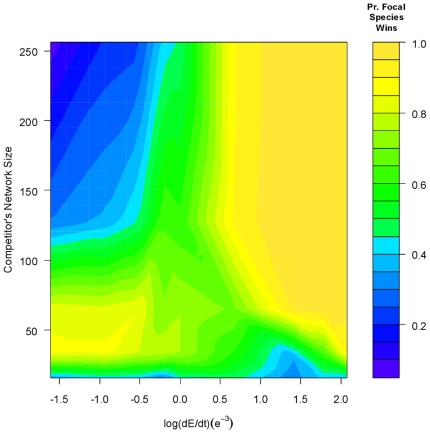
Probability that the focal species wins competition as a function of
competitor network size and log(dE/dt).At slower rates of environmental change, the probability that the focal
species will win declines with an increase in the size of the
competitor's network. With the exception of a competitor with a 64-gene
network, when the rate of environmental change is high, the probability of
the focal species winning increases as the competitor's network size
increases. 64-gene networks are never superior to the 16-gene network at the
rates examined here. Note that this figure, produced using the
akima package for R [54], interpolates data to
produce the surface, whereas the predictor variables (network size,
recombination rate, and dE/dt) are categorical in the simulations and
statistical analyses.